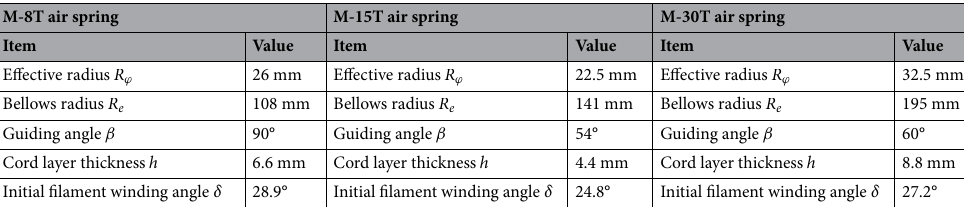
Table 1. Main design parameters of air springs.